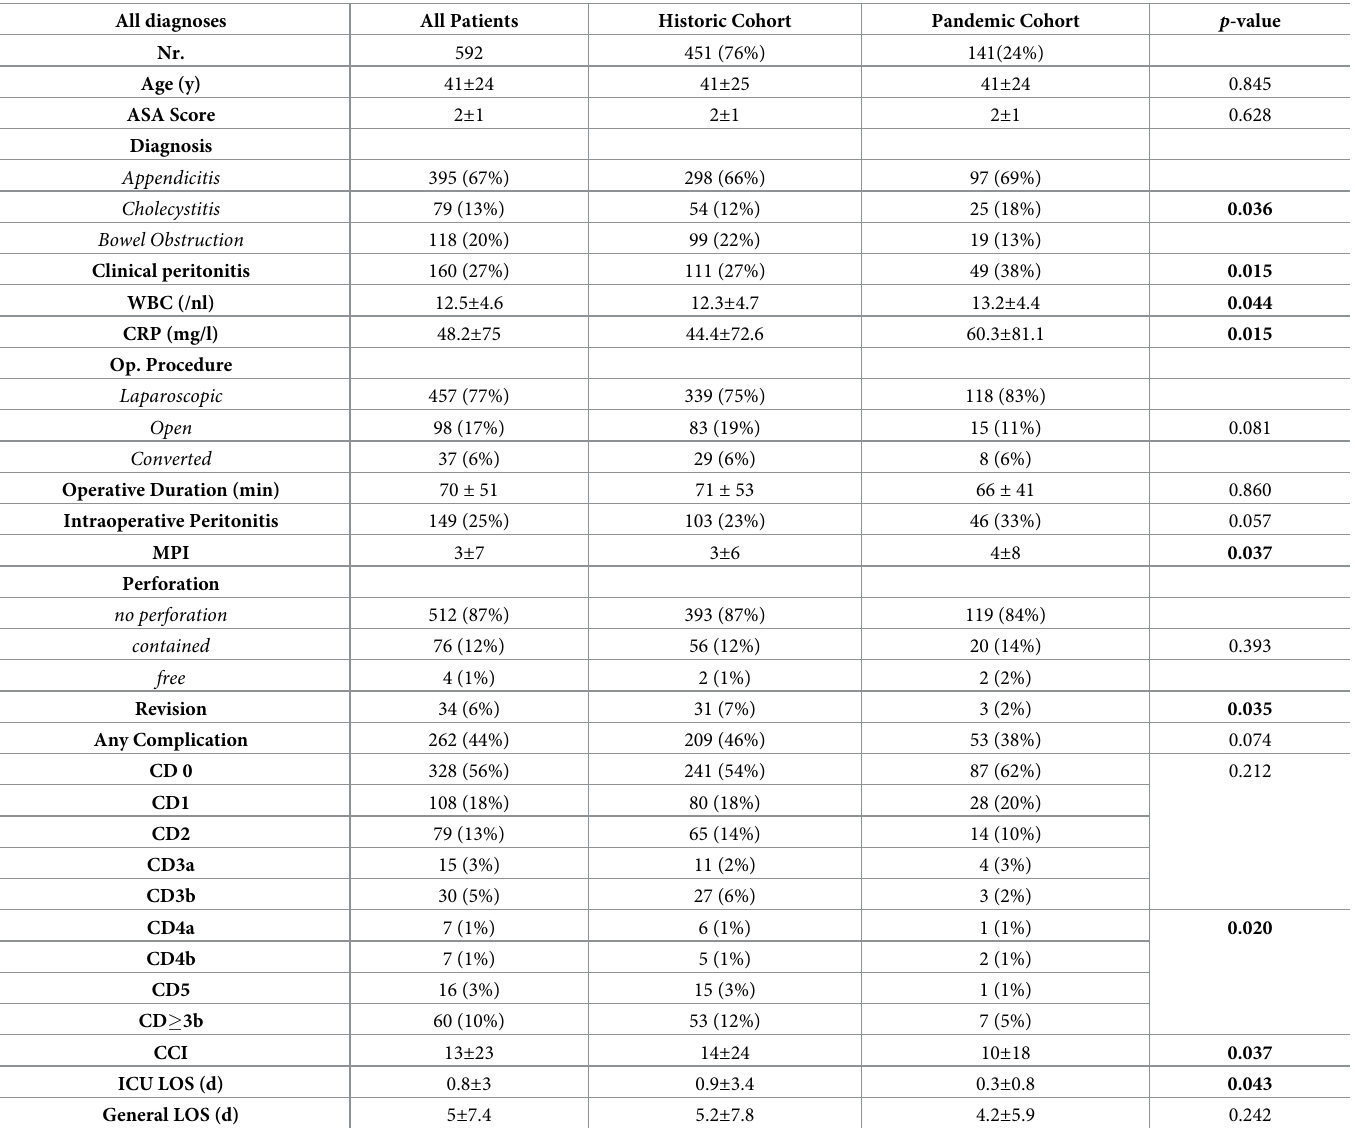
anaesthesiologists score, WBC, White blood cell count; CRP, C-reactive protein; MPI, Mannheim peritonitis index score; CD, Clavien-Dindo score; CD � 3b, CD score equal or higher than 3b (severe complications), CCI, comprehensive complication index; ICU LOS, intensive care unit length of stay; LOS, Length of